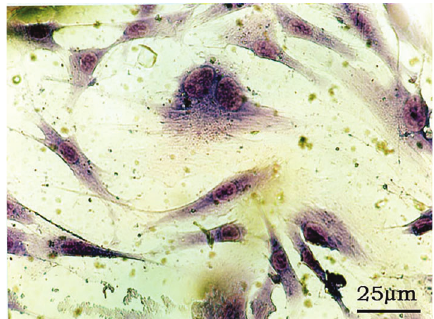
Figure 5. Dark tight nodules formed at 14 days in fi broblasts induced with 40 m g/mL fi bronectin. Phase contrast microscope, (cid:1) 100.